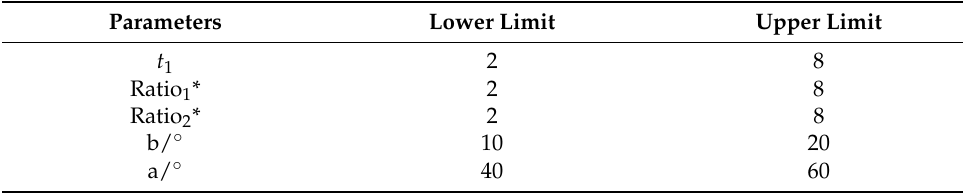
Table 2. Limits of optimization variables.